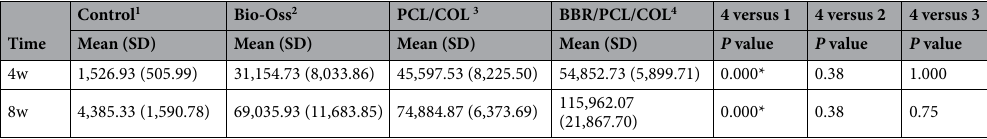
Table 2. Histomorphometric analysis results of newly formed bone area in the defect edge (NBA, μm 2 ) (n = 6). SD : standard deviation. 1: Control; 2: Bio-Oss; 3: PCL/COL; 4: BBR/PCL/COL. One-way analysis of variance. *Statistically significant at P <